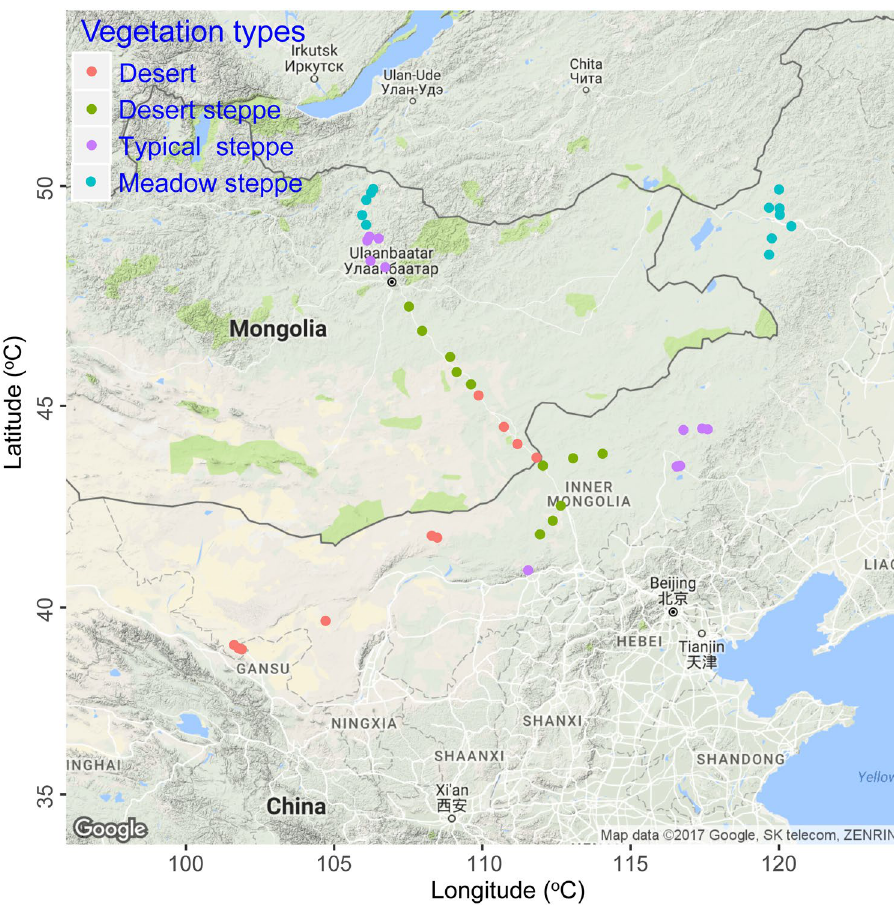
Figure 1. Locations of the study sites along the east–west (Inner Mongolia) and north–south (Mongolia) transects across the Mongolian Plateau 5, 26 . The map was created by the Google Maps module in R (https:// cran.r-project.org/package =